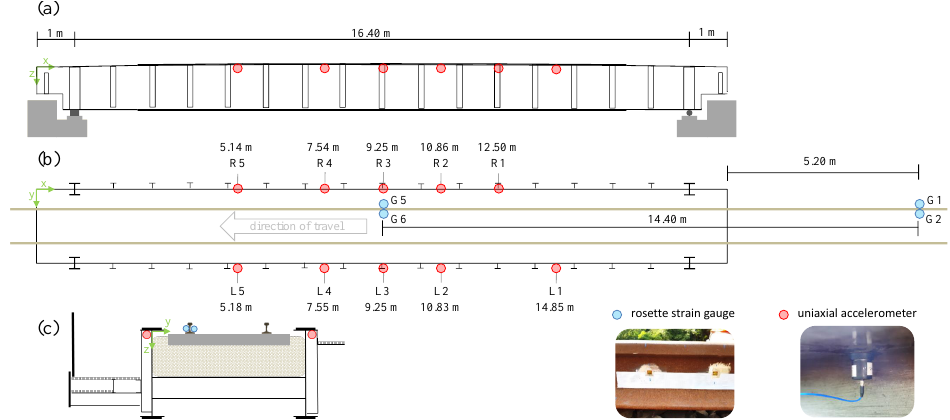
Figure 2. Photos of the investigated structure.